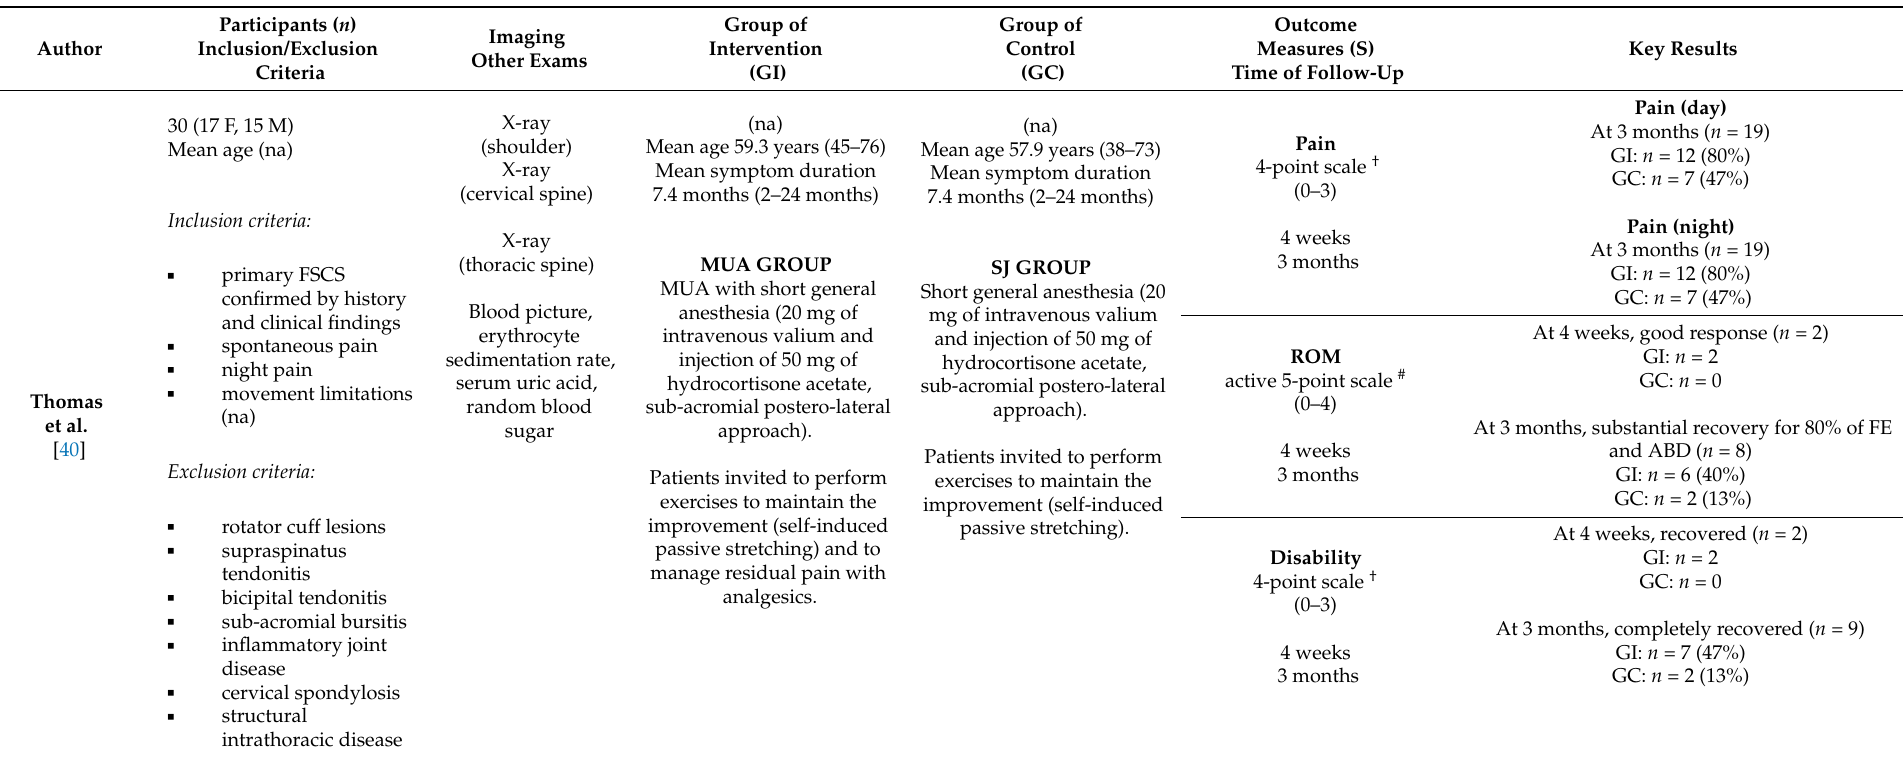
Table 2. Main characteristics of populations, interventions and outcome measures of included